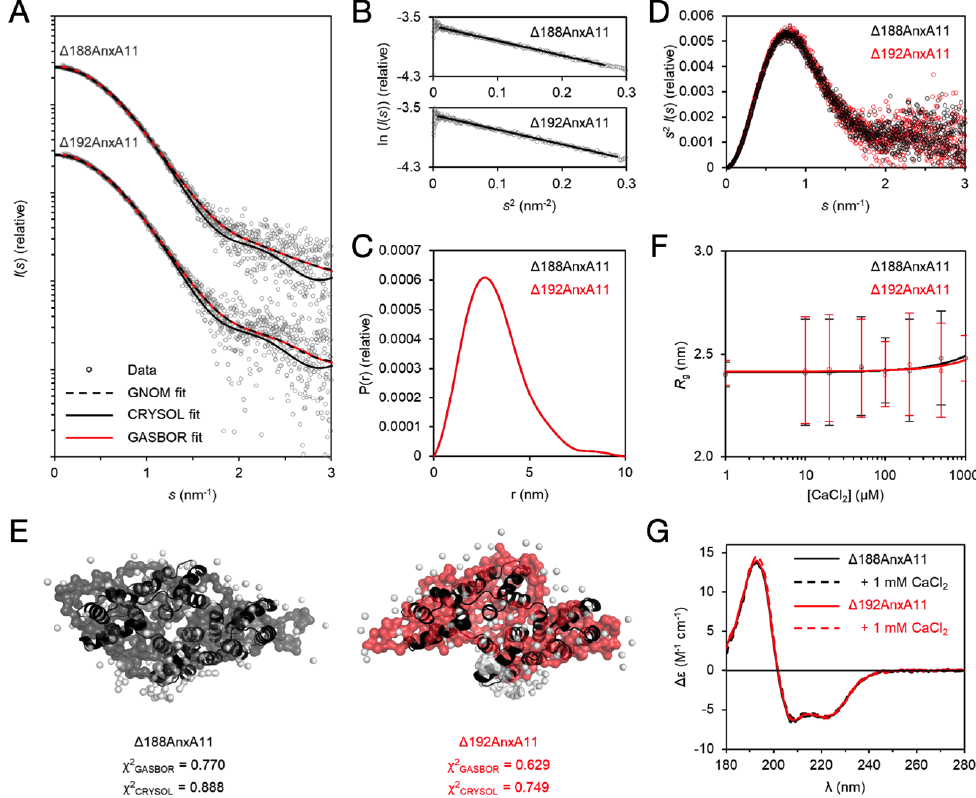
Figure 7. SAXS and SRCD analysis of ∆ 188AnxA11 and ∆ 192AnxA11. ( A ) SAXS data for ∆ 188AnxA11 and ∆ 192AnxA11 have been offset for clarity. GNOM, GASBOR, and CRYSOL fits are plotted over the measured data to denote the accuracy of distance distribution analysis, ab initio modeling, and theoretical scattering calculated from the crystal structure. ( B ) Guinier analysis. ( C ) Distance distribution diagram from GNOM. ( D ) Kratky plot of the SAXS data. ( E ) GASBOR ab initio models based on the SAXS data. The crystal structure (black) has been fitted inside. χ 2 values of the GASBOR and CRYSOL fits are indicated. ( F ) R g as a function of CaCl 2 concentration. The error bars represent the fitting error from Guinier analysis. ( G ) SRCD spectra of ∆ 188AnxA11 and ∆ 192AnxA11 in the presence and absence of 1 mM CaCl 2